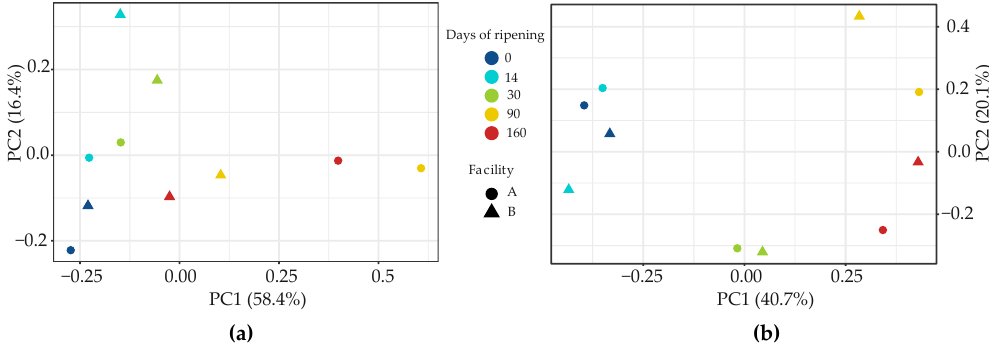
Figure 3. Principal Coordinates Analysis (PCoA) of the 16SrRNA gene or ITS2 Amplicon Sequence Variants (ASVs) based on Bray-Curtis distances for bacterial ( a ) or fungal ( b ) beta-diversity investigation, respectively. Samples are colored according to the ripening day. The shape of the symbols corresponds to the ripening facility (A, circles; B,